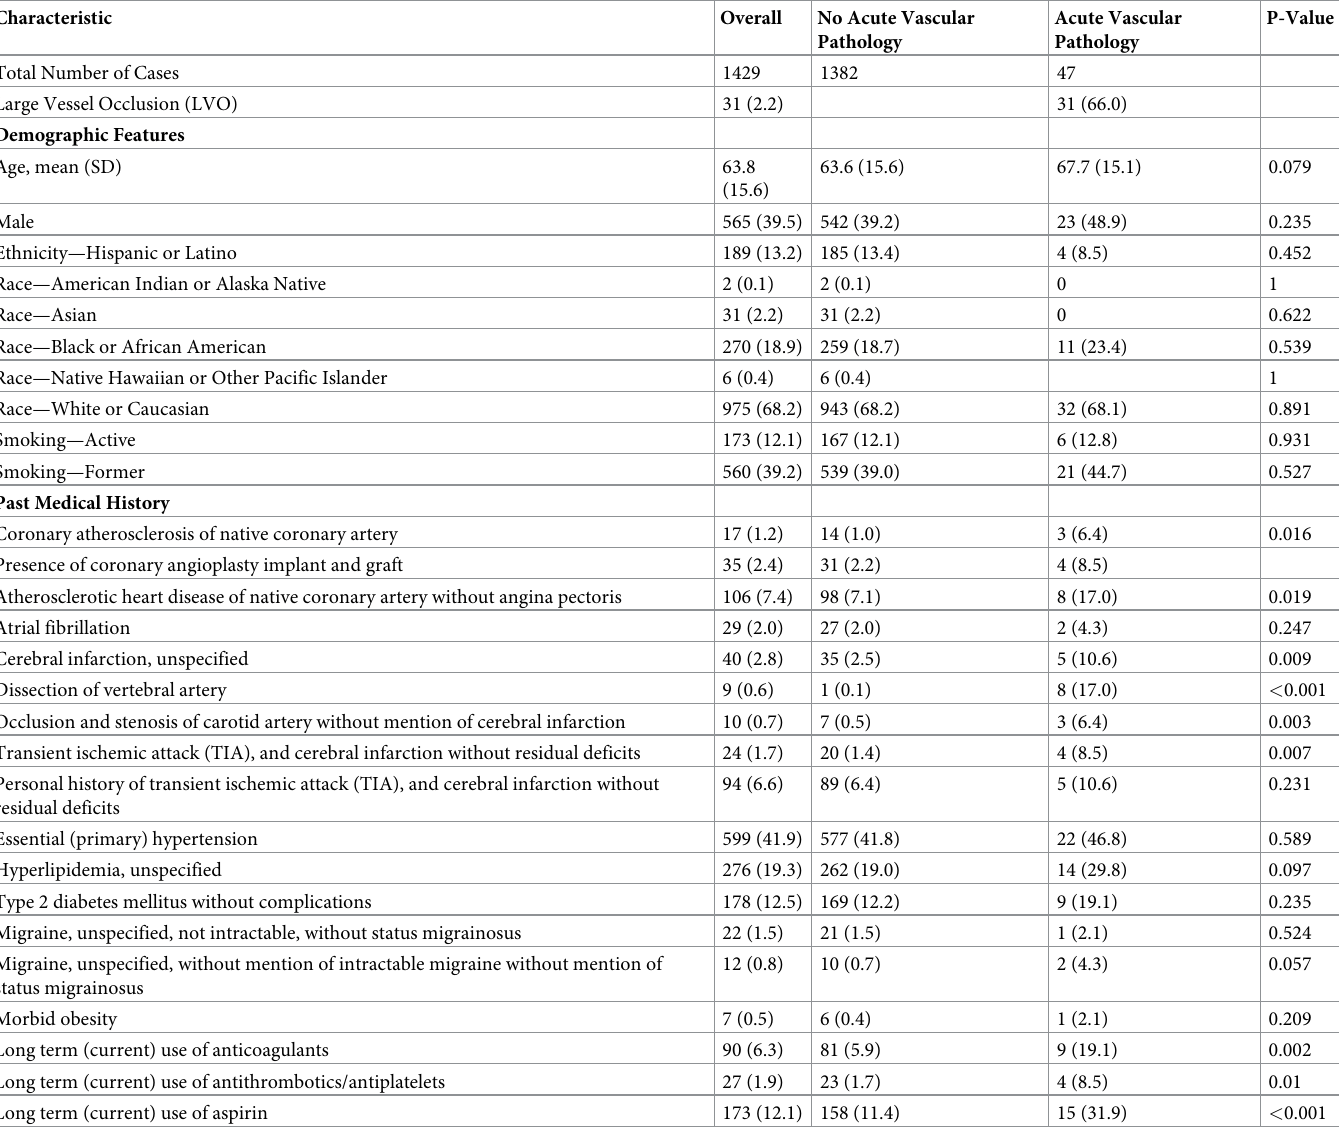
Table 1. Demographic and characteristics of cases with and without acute vascular